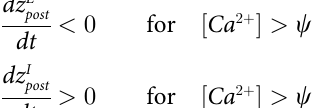
must gain inhibitory and lose excitatory inputs to return to their balanced state. Hence, the formation of new inhibitory dendritic elements and the removal of their excitatory counter- parts occurs in a regime where neuronal activity exceeds the required amount (([ Ca 2+ ] > ψ ) in Fig 5A):